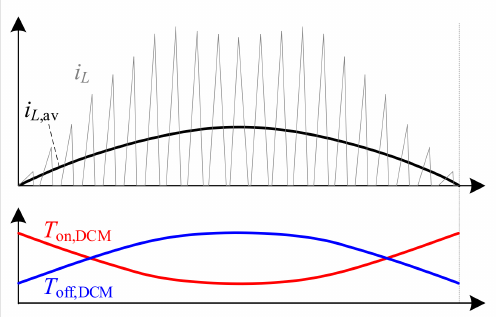
Figure 2. Variable on-time for PWM to achieve sinusoid i L ,av .